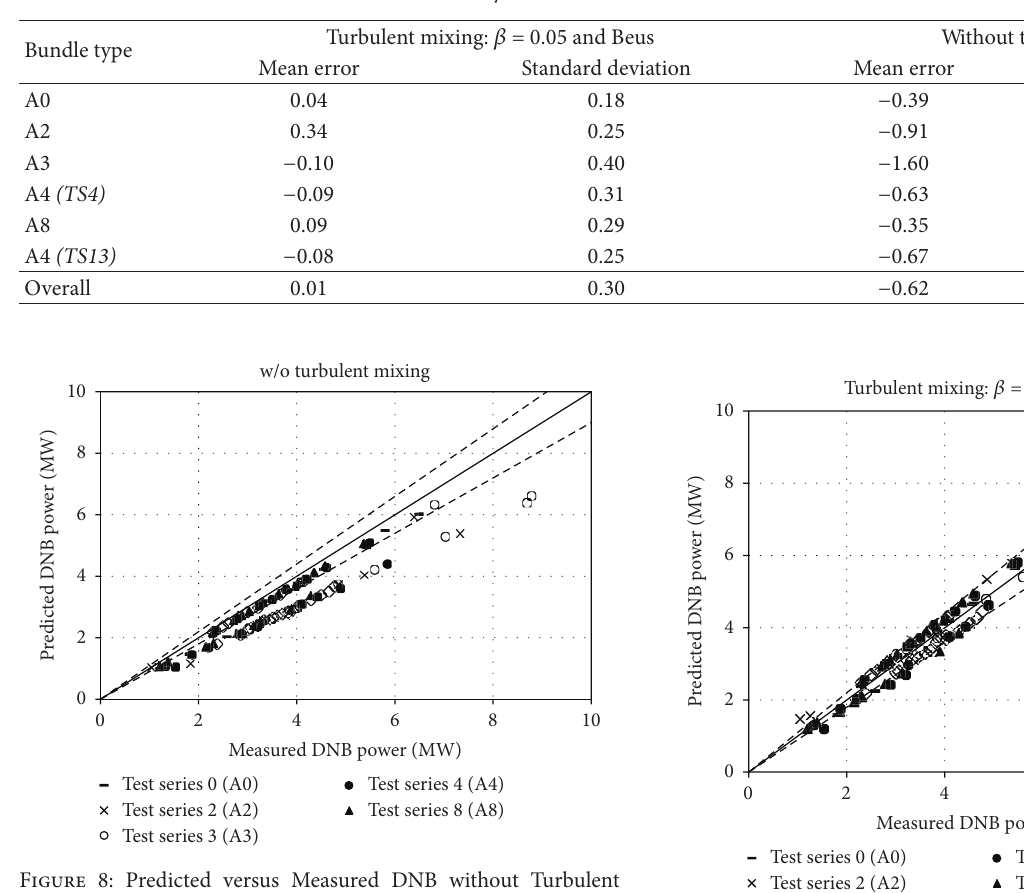
T 7: Statistical analysis for the PSBT test assemblies A0, A2, A3, A4, and A8.